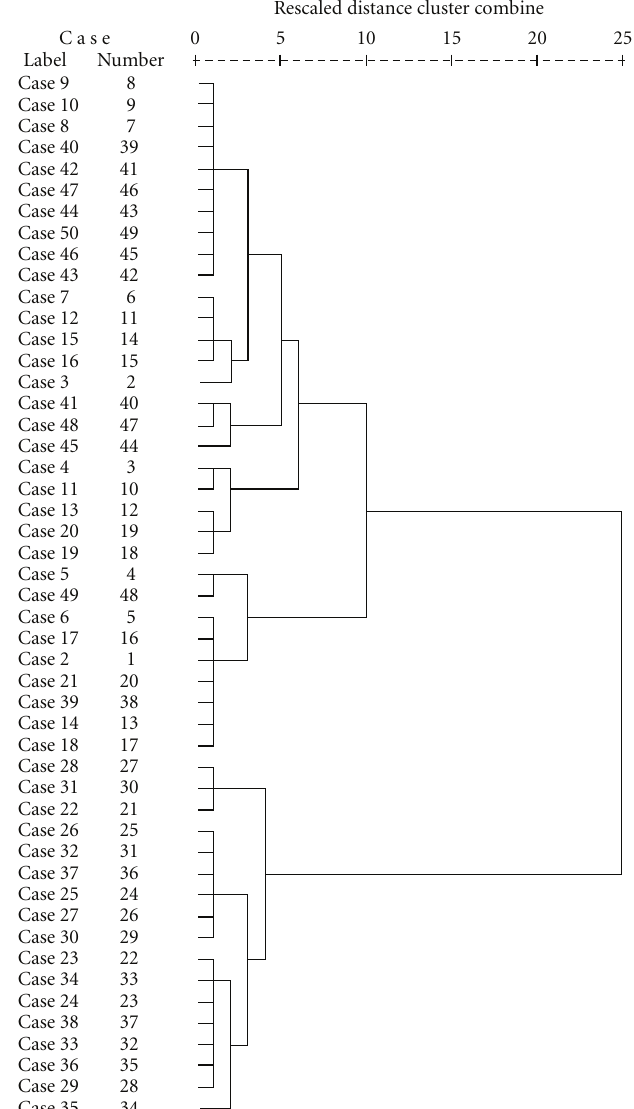
Figure 1: A hierarchical cluster analysis (Ward’s method) of subjects with winter SAD and S-SAD ( N = 49) based on baseline data taken from four measures: the fatigue questionnaire (FQ), the Epworth Sleepiness Scale (ESS), and the two subscales, the HAMD-21 and Atyp-8 (from the depression scale